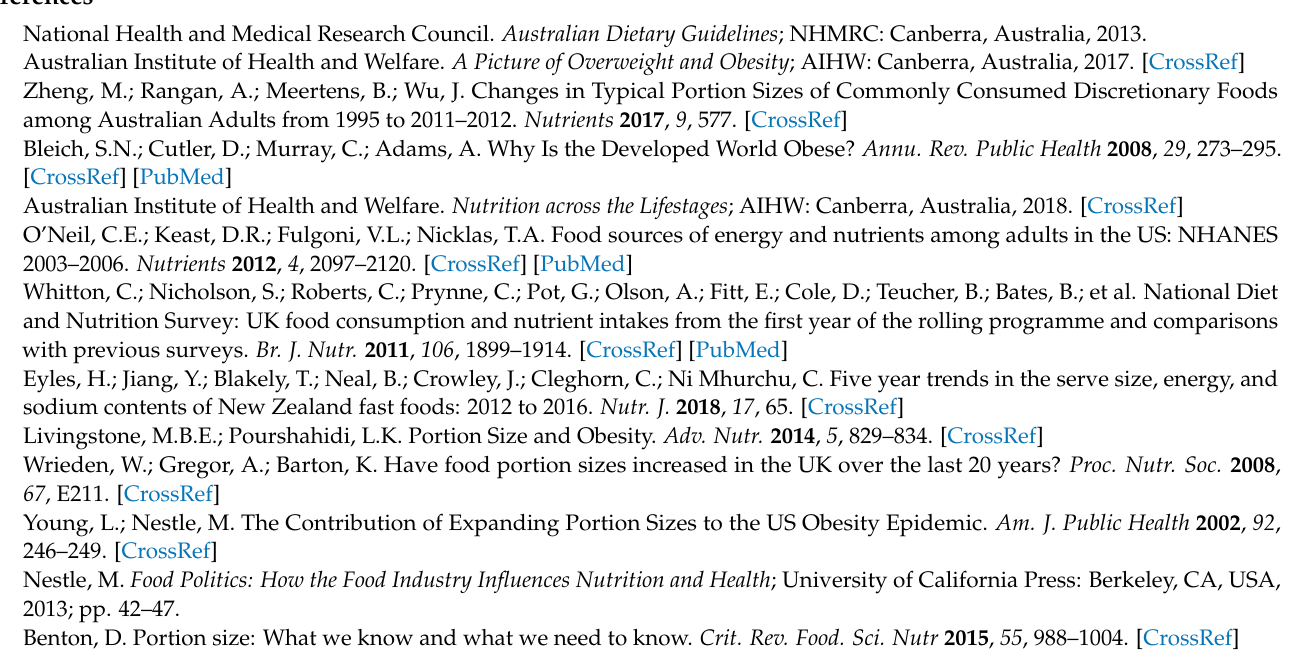
Table S2: Supplementary information of intervention studies comparing smaller versus larger single pack containing different total serving size of energy-dense, nutrient-poor snacks and drinks, Table S3: Supplementary information of intervention studies comparing smaller multipacks versus larger pack(s) containing same total serving size of energy-dense, nutrient-poor snacks and drinks, Table S4: Supplementary information of intervention studies comparing packaged versus unpackaged energy- dense, nutrient-poor containing same total serving size, Table S5: Risk of bias assessment using the Joanna Briggs Institute Checklist for randomised controlled trails ( n = 26), Table S6: Risk of bias assessment using the Joanna Briggs Institute Checklist for quasi-experimental studies ( n = 20), Table S7: Risk of bias assessment using the Joanna Briggs Institute Checklist for qualitative research ( n = 1). Author Contributions: Conceptualization, Q.L., L.Y.T. and A.R.; methodology, Q.L., L.Y.T. and